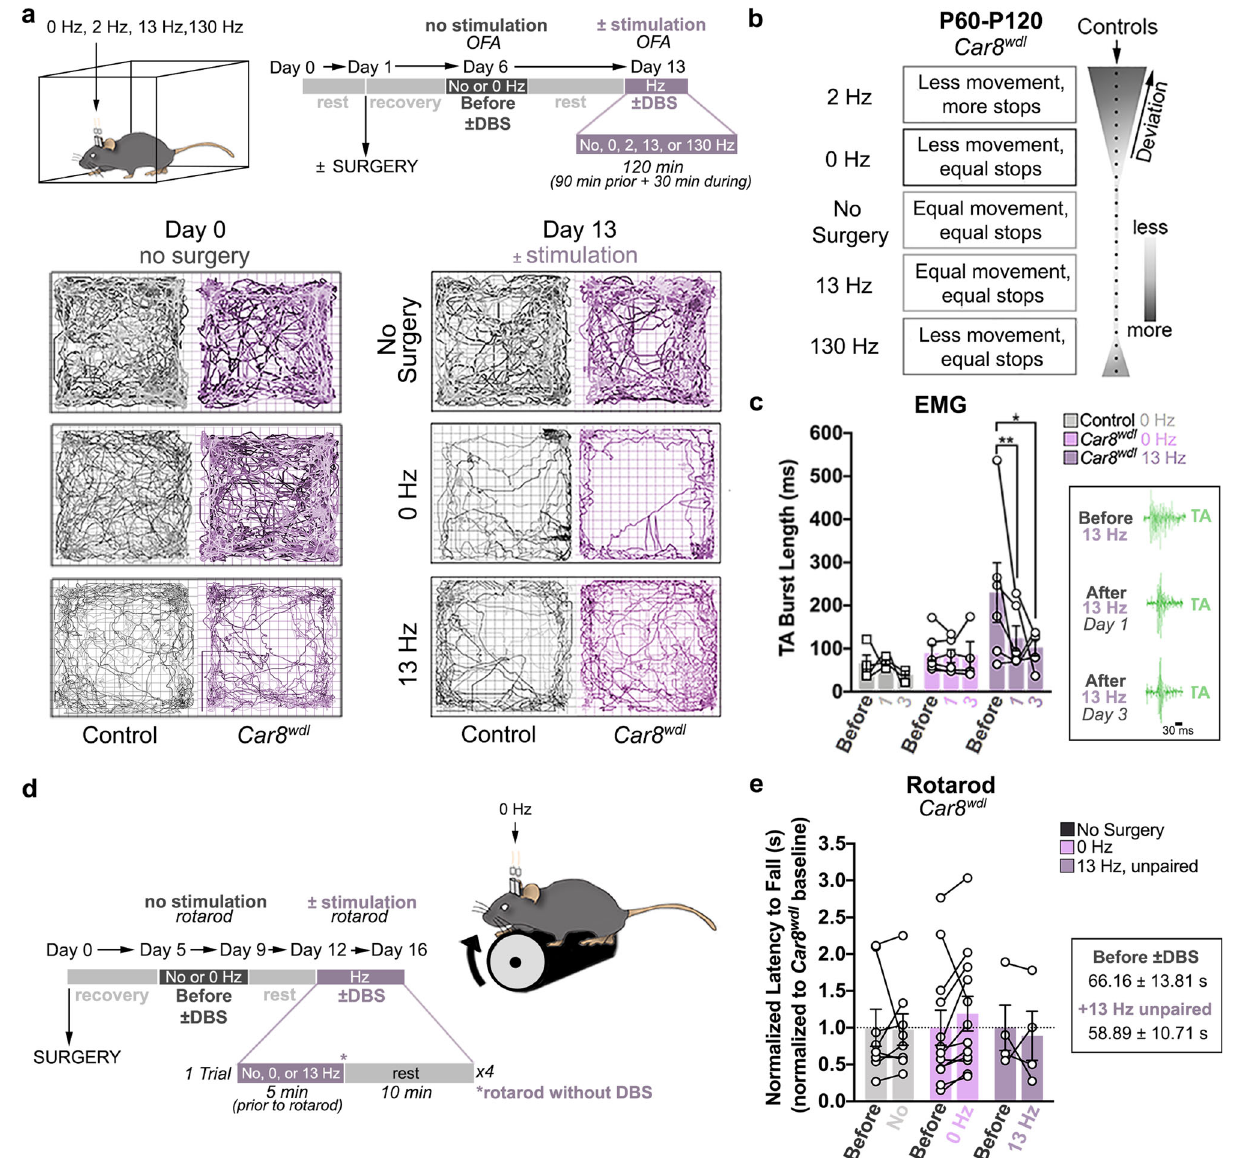
Fig. 3 Cerebellar DBS promotes locomotor improvements for ongoing motor function. a Schematic and experimental timeline of the open fi eld assay (OFA) used in combination with DBS to measure movement and movement time. Example traces reveal that 13 Hz DBS maintains the movement of Car8 wdl mice. b No other stimulation frequency other than 13 Hz preserves the movement of Car8 wdl mice. Schematic summarizes the effects of cerebellar stimulation on Car8 wdl movement and compares how alterations cause Car8 wdl behavior to deviate from that of controls. The darker the gray, the more stimulation impacted Car8 wdl movement. The wider the schematic, the more Car8 wdl motor behavior deviated from control motor behavior (black dotted vertical line). The schematic aligns with the stimulation frequencies on the left. c TA muscle fi ring in Car8 wdl mice remains reduced after stopping DBS (Day 1: p = 0.0013; Day 3: p = 0.0492). Example traces from a 13-Hz stimulated Car8 wdl mouse are outlined. Before = Before ±DBS, Day 1; 1 = After ±DBS, Day 1; 3 = After ±DBS, Day 3. n = 24 biologically independent animals (Control, 0 Hz: n = 4; Control, 13 Hz: n = 8; Car8 wdl , 0 Hz: n = 6; Car8 wdl , 13 Hz: n = 6) over 24 independent experiments on Day 1. n = 15 biologically independent animals (Control, 0 Hz: n = 3; Control, 13 Hz: n = 3; Car8 wdl , 0 Hz: n = 4; Car8 wdl , 13 Hz: n = 5) over 15 independent experiments on Day 3. d Experimental timeline and schematic of our unpaired behavioral paradigm. The mutants perform on the rotarod without DBS. e Car8 wdl mice need to be stimulated while on the rotarod to receive bene fi ts ( p = 0.9999). The black dotted line demarcates the mutant baseline (normalized to y = 1.00). The latency to fall values for each Car8 wdl mouse were plotted, before and during unpaired DBS. n = 24 biologically independent animals (No Surgery: n = 8; 0 Hz: n = 12; unpaired 13 Hz: n = 4) over 24 independent experiments. * p < 0.05; ** p < 0.01; three-way ANOVA, repeated measures with mixed-effects ( c ); two-way ANOVA, repeated measures ( e ); Sidak ’ s multiple comparisons test ( c , e ); mean ±